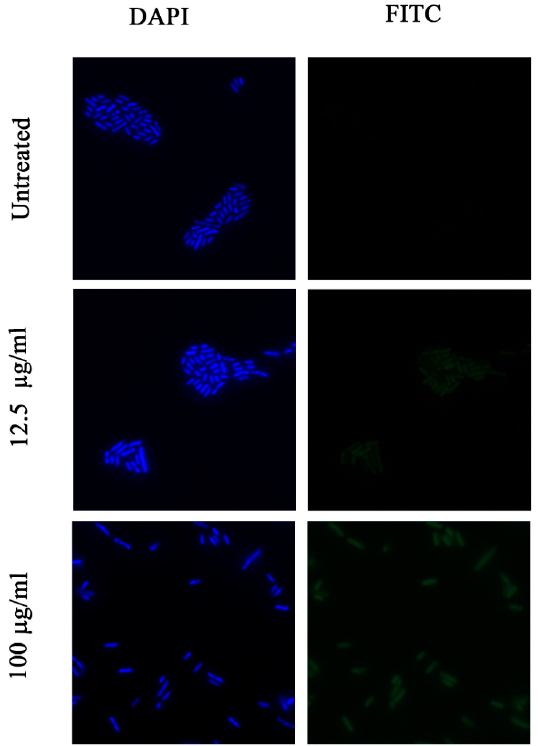
Figure 5. Images of fluorescence of DAPI and FITC before and after treatment of SP4 with concentrations of 100 µg/mL and close to MIC.